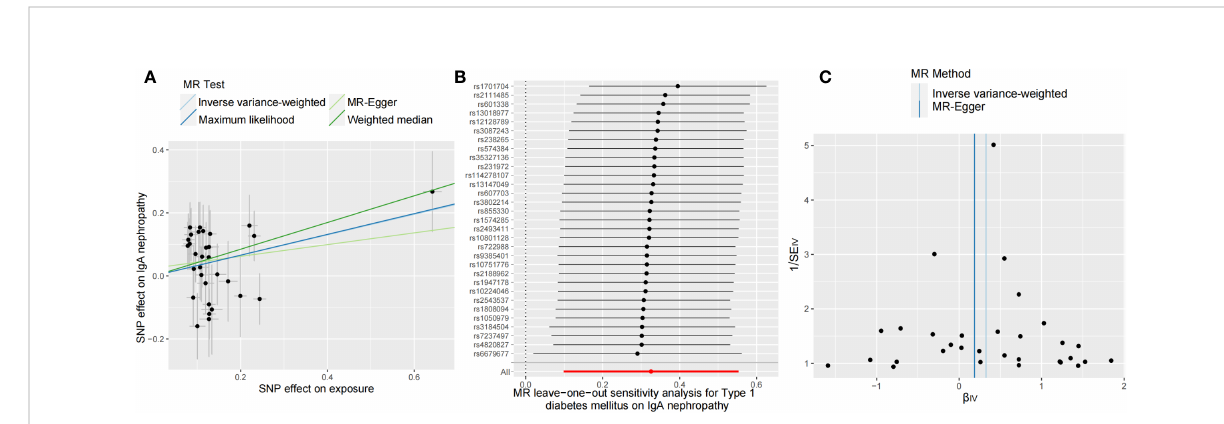
FIGURE 2 Scatter plot (A) , leave-one-out test (B) , and funnel plot (C) for genetically determined type 1 diabetes mellitus on IgA nephropathy risk. MR, Mendelian